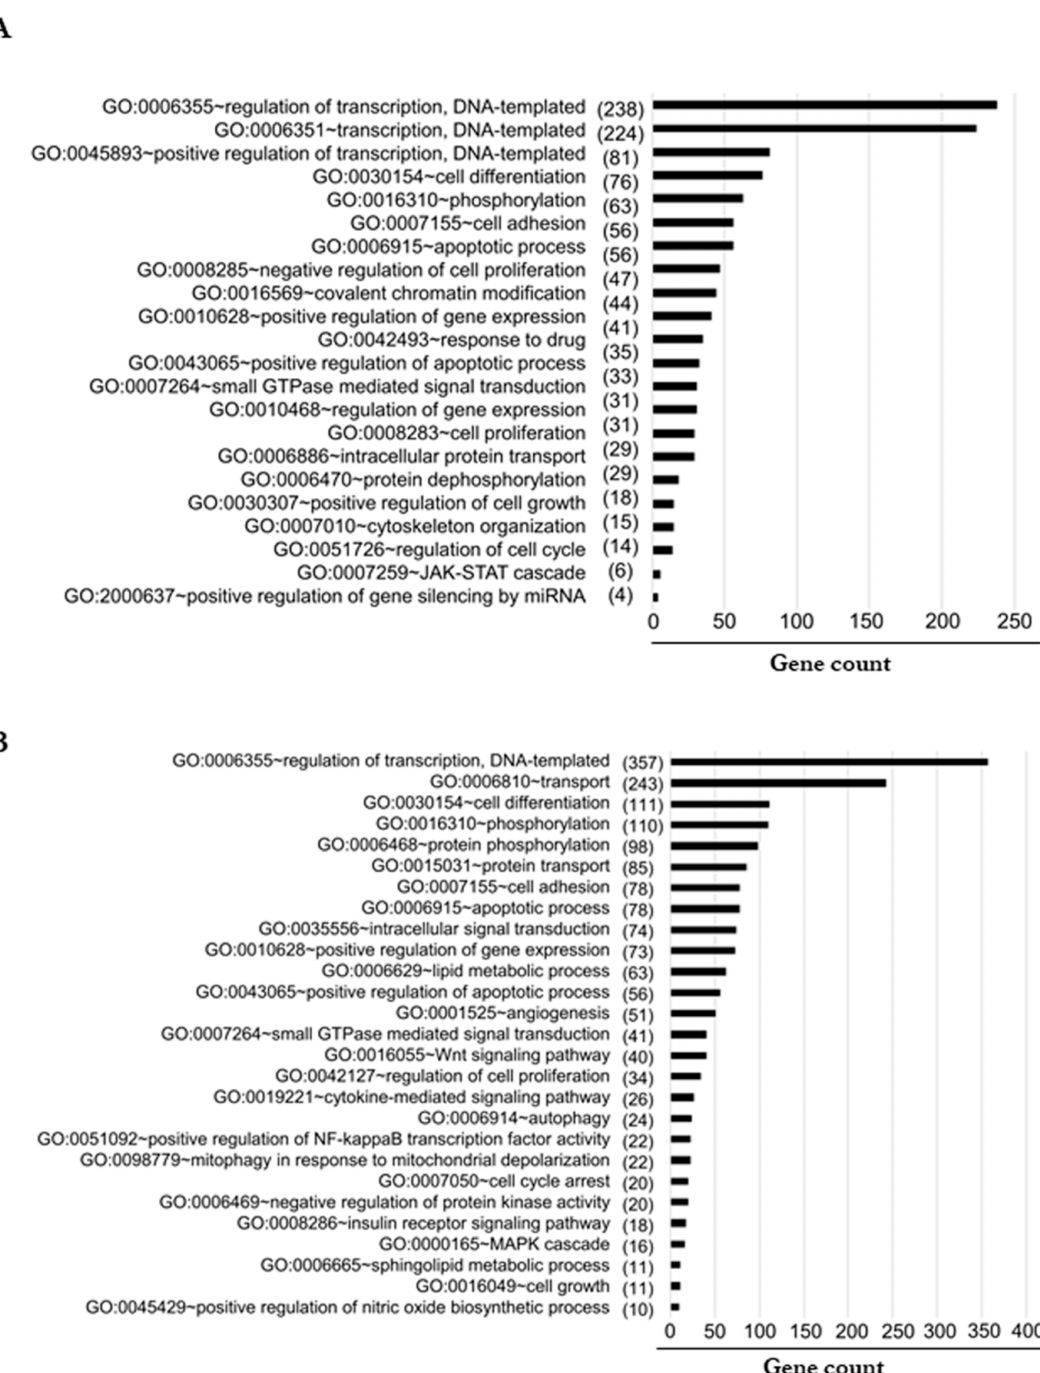
Figure 8. ( A , B ) Functional enrichment analysis using DAVID shows the significantly enriched biological process sorted in descending order based on the number of genes given in the parenthesis identified as targets for the downregulated ( A ) and upregulated ( B ) miRNA enriched in each